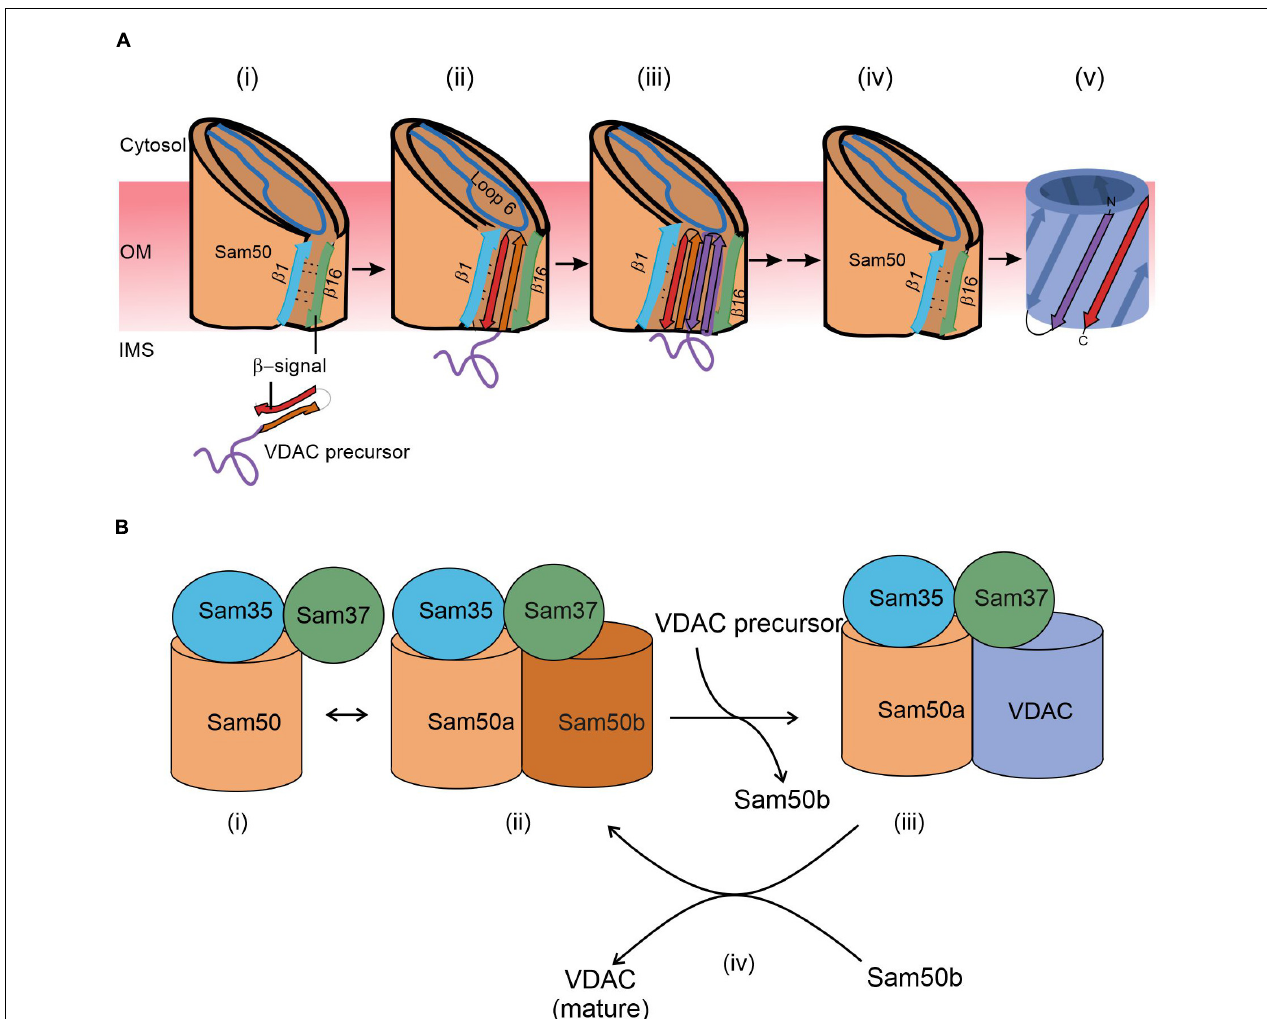
FIGURE 2 | A working model for the final steps of the membrane integration of VDAC. (A) Lateral insertion (adapted from Figure 8; Höhr et al., 2018). (i) VDAC precursors approach the outer membrane from the IMS. (ii) The C-terminal β -signal of VDAC precursor interferes with the Sam50 structure by binding to the β 1 strand of Sam50 and disrupting the β 1– β 16 interactions within Sam50. This enforces opening of a lateral gate. (iii) The initial opening is followed by sequential insertion of additional precursor β -hairpins through the lateral gate of Sam50. (iv) The lateral gate of Sam50 re-closes to (v) release the fully formed β -barrel of VDAC into the MOM. (B) Barrel switching (based on Takeda et al., 2021). In its substrate-free state, the SAM complex is in equilibrium between the “monomeric” state consisting of Sam50a, Sam35, and Sam37 (i) and a “dimeric” species that contains a second (Sam50b) barrel (ii). The gradually formed VDAC barrel displaces Sam50b (iii). Finally, the fully folded VDAC molecule dissociates from the complex to be replaced by Sam50b (iv).